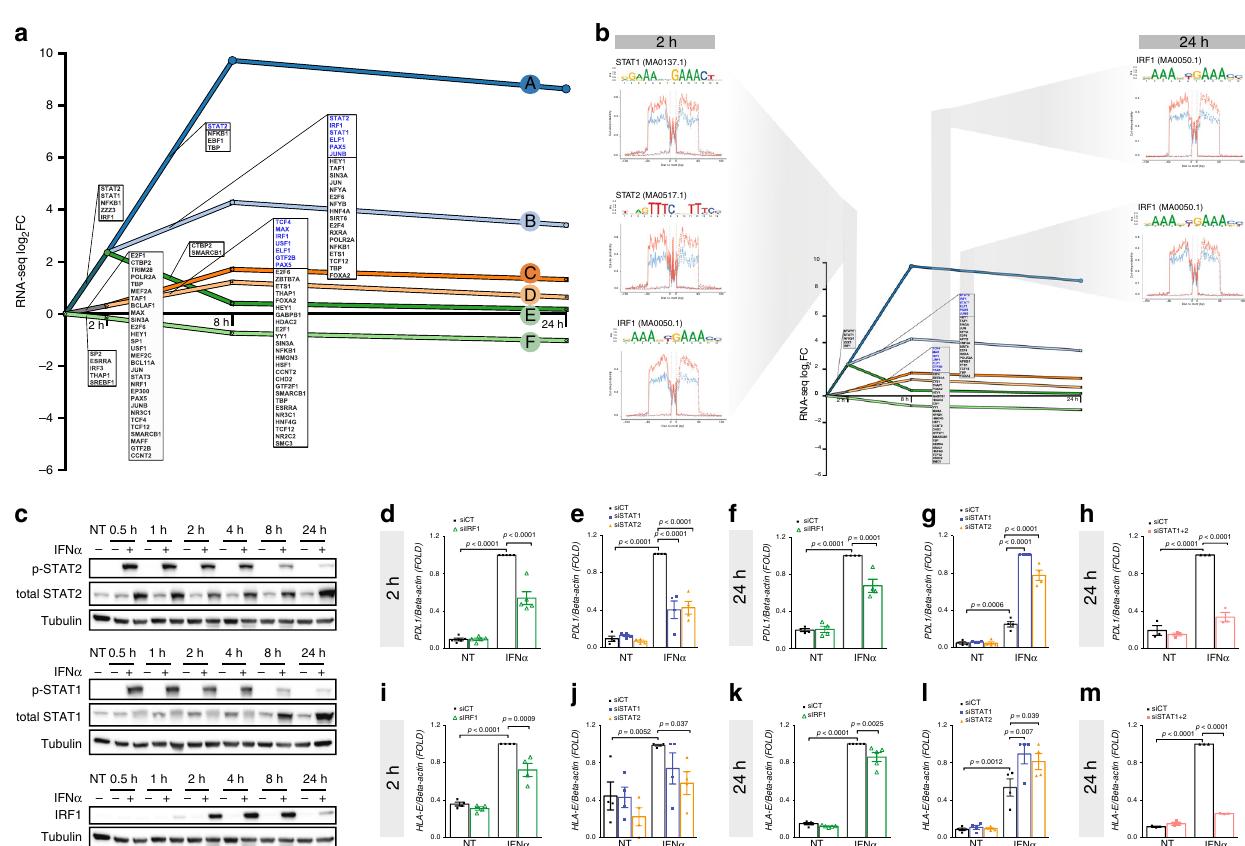
Fig. 2 IRF1, STAT1 and STAT2 regulate IFN α -induced transcription and the expression of checkpoint proteins. a The regulatory paths summarize the temporal patterns of the differentially expressed genes (DEG) detected by RNA-seq (|log 2 FC|> 0.58 and FDR < 0.05, n = 5) (evaluated by DREM 25 ). The x axis represents the time and the y axis the mRNA log 2 FC. Each path corresponds to a set of co-expressed genes. Split nodes (circles) represent a temporal event where co-expressed genes diverge in expression. In blue are the TFs upregulated at the respective time points of the RNA-seq that may regulate the pathways. b IFN α promoted TFs footprint deepening in open chromatin regions (OCR) associated to genes from the indicated DREM pathways. OCRs were associated to the nearest gene TSS with a maximum distance of 1 Mb. Previously annotated TF matrices 79 were used to identify differential DNA-footprints induced by IFN α (blue lines = untreated cells, red lines = IFN α (24 h), dashed lines = reverse strand, continuous line = forward strand, Methods, n = 4). c Time course pro fi le of STAT1, STAT2 and IRF1 protein activation in EndoC- β H1 cells exposed to IFN α (representative of four independent experiments). d – m EndoC- β H1 cells were transfected with an inactive control siRNA (siCT) or previously validated 7,24 siRNAs targeting IRF1 (siIRF1), STAT1 (siSTAT1), STAT2 (siSTAT2) or STAT1 plus STAT2 (siSTAT1 + 2). After 48 h the cells were exposed to IFN α The values were normalized by the housekeeping gene β -actin (mRNA) and then by the highest value of each experiment considered as 1 (for h and m ( n = 3); for e – g , i , j and l ( n = 4); for d , k ( n = 5)), ANOVA with Bonferroni correction for multiple comparisons ( d – m ). Values are mean ± SEM ( d – m ). Source data are provided as Source Data fi of differentially expressed genes (DEG) from all RNA-seq time as antigen processing and presentation, responses to viruses, points (Supplementary Data 3) was analyzed using the dynamic apoptosis and NK/T-cell responses (Supplementary Fig. 4a, b); regulatory events miner (DREM) model 23 . This approach iden- groups of genes associated to protein modi fi cation and degrada- ti fi ed six patterns of co-expressed genes (Fig. 2a); 5 out of 6 tion were also present (Supplementary Fig. 4a, c). Furthermore, pathways had an early peak of induction (2 or 8 h), which then genes related to endoplasmic reticulum (ER) stress, another post- decreased or remained stable until 24 h (Fig. 2a). The model transcriptional mechanism that downregulates translation of compared the frequency of TF binding sites in the gene pro- many mRNAs 20 , were also upregulated by IFN α at both the moters between divergent branches of co-expressed genes, mRNA and protein levels (Supplementary Fig. 4d). These fi ndings are in line with our previous observations 7 and were assuming that these TFs are responsible for the observed differ- ences in gene expression pro fi les (Fig. 2a). This was compared con fi rmed here in independent samples for two key ER stress with the TF occupancy determined by assaying the protection of markers, namely the transcription factor ATF3 21 and the ER chaperon HSPA5 (also known as BiP/GRP78) 22 (Supplementary the bound sequence to ATAC-seq transposase cleavage (foot- Fig. 4e – h). ER stress often decreases translation, which may print) (Supplementary Fig. 5a and Methods). There were foot- explain the weak association observed between mRNA and prints for the transcription factors IRF1, STAT1 and STAT2, protein expression in downregulated mRNAs and proteins which were deepened upon IFN α exposure in pathway B (which (Fig. 1g). had the highest transcriptional upregulation at 2 h) and for IRF1 in two independent pathways, namely B and D at 24 h (Fig. 2b). Western blot analysis con fi rmed the activation of these TFs (Fig. 2c). STAT1 and STAT2 phosphorylation peaked between 0.5 IRF1, STAT1 and STAT2 are key regulators of IFN α signaling . and 1 h and then returned to near-basal levels at 24 h, while IRF1 To identify the key transcription factors involved, the expression